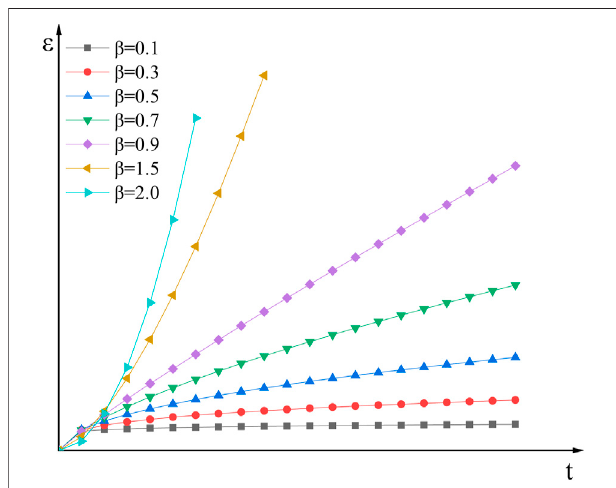
FIGURE 3 | Creep curves of soft-matter element.